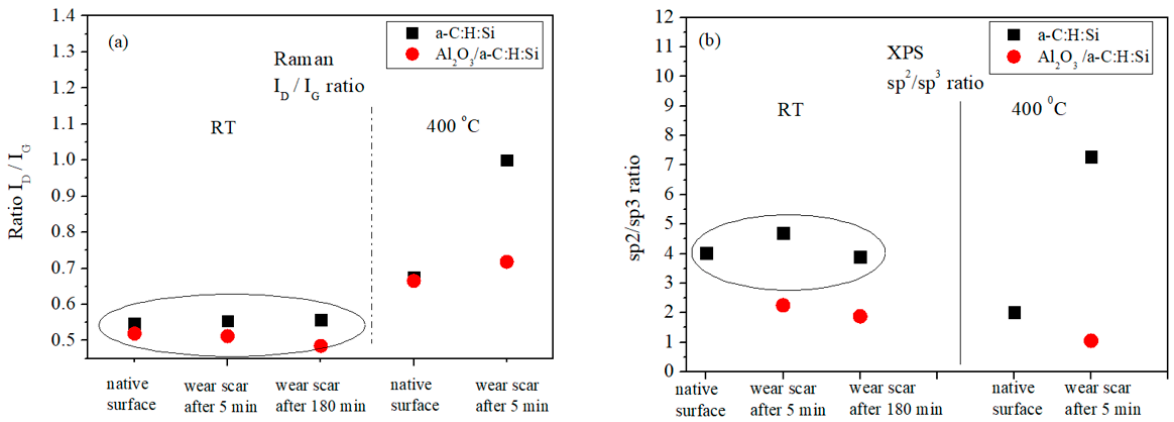
Figure 13. Summary of the results of ( a ) Raman and ( b ) XPS